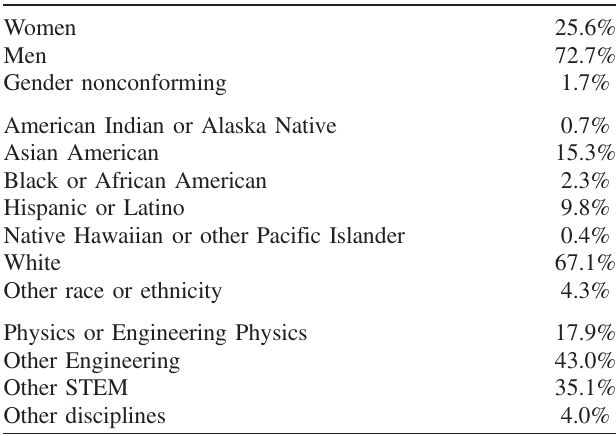
TABLE I. Self-reported gender, race, ethnicity, and major of students enrolled in the course in Spring 2018. There are around 1200 students in total included in this